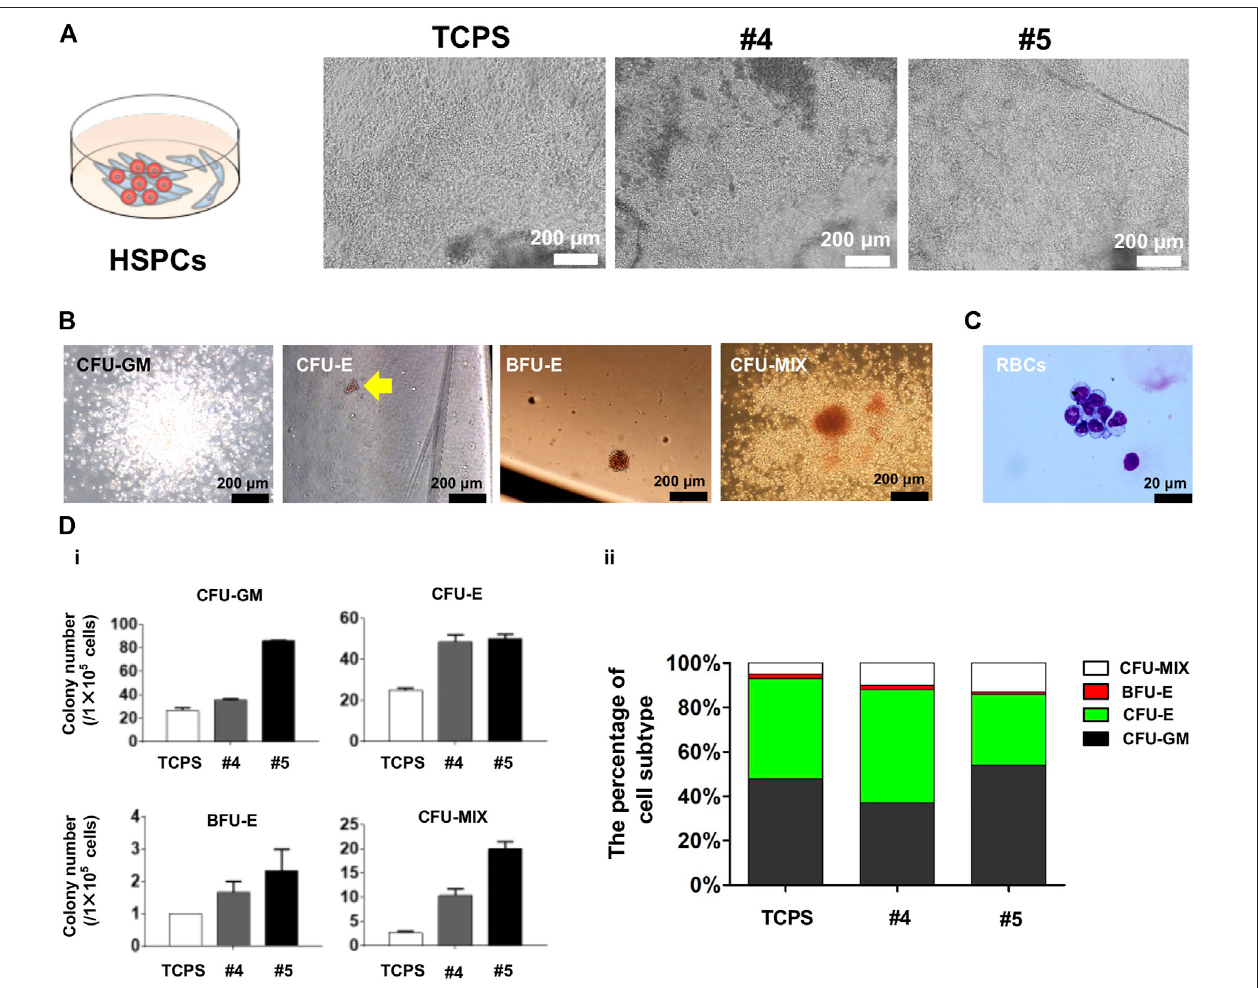
FIGURE 5 | Characterization of blood-like cells derived from cSAP-cultured hESCs. (A) Cell morphology of hESC-HCs during co-culture with stromal AMG3 cells; (B) Colony culture assay after hESCs were cultured on cSAPs or TCPS in standard feeder-free culture method; (C) May-Grunwald-Giemsa (MGG) staining of erythroid cells differentiated from cSAP-derived hESCs; (D) The statistical analysis of (i)colony numbers ofCFU-GM, CFU-E, BFU-E, or CFU-MIX colonies, and (ii) the percentage of colony subtype.